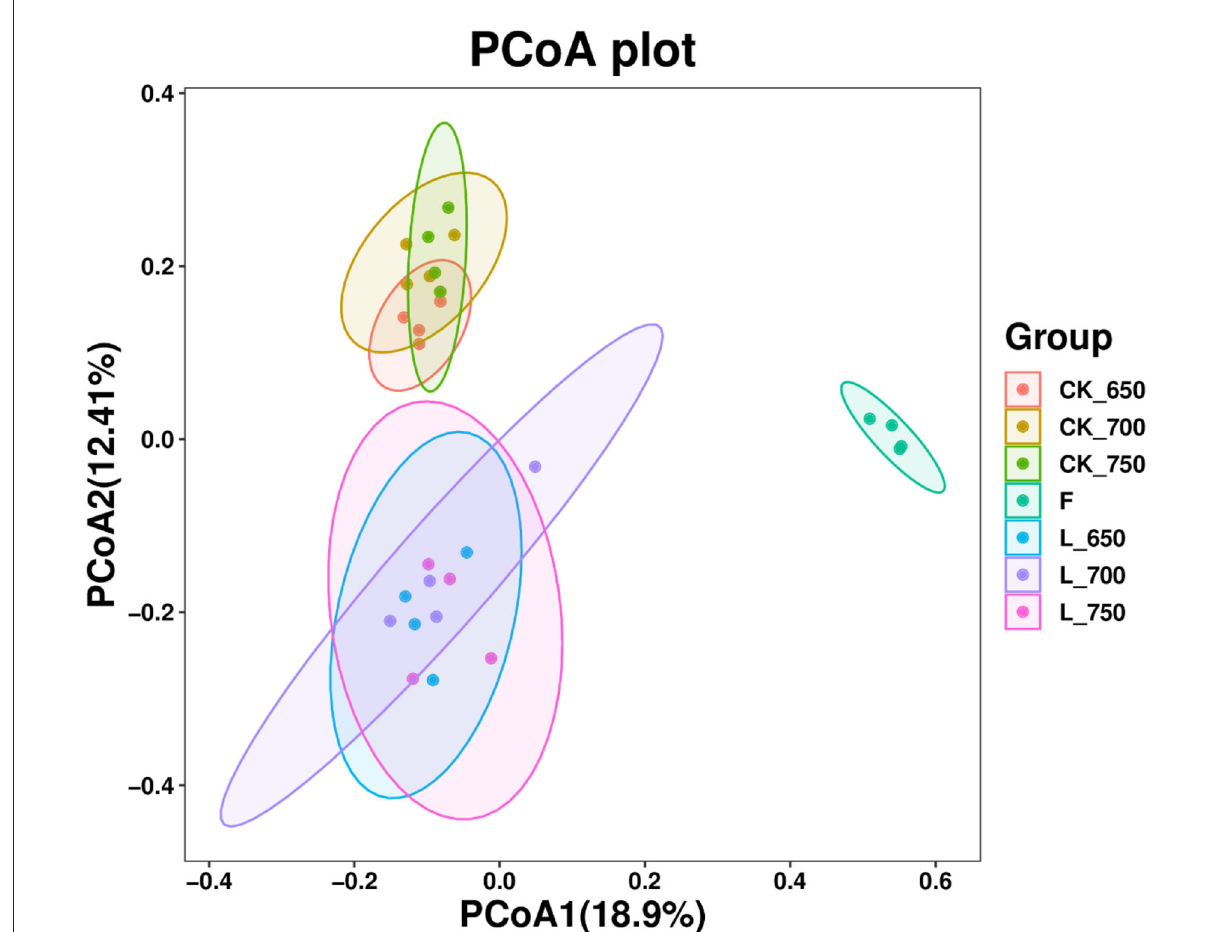
FIGURE1 Principal coordinates analysis (PCoA) of bacterial community in sweet sorghum silages ( n = 4). CK, ensiling of sweet sorghum with 2.00 ml/kg fresh weight (FW) of distilled water at 650 (CK_650), 700 (CK_700), and 750 kg/m 3 (CK_750) of density, respectively; L, ensiling of sweet sorghum with 2.00 g/t FW of lactic acid bacteria (LAB) inoculant and 2.00 ml/kg FW of distilled water at 650 (L_650), 700 (L_700), and 750 kg/m 3 (L_750) of density,